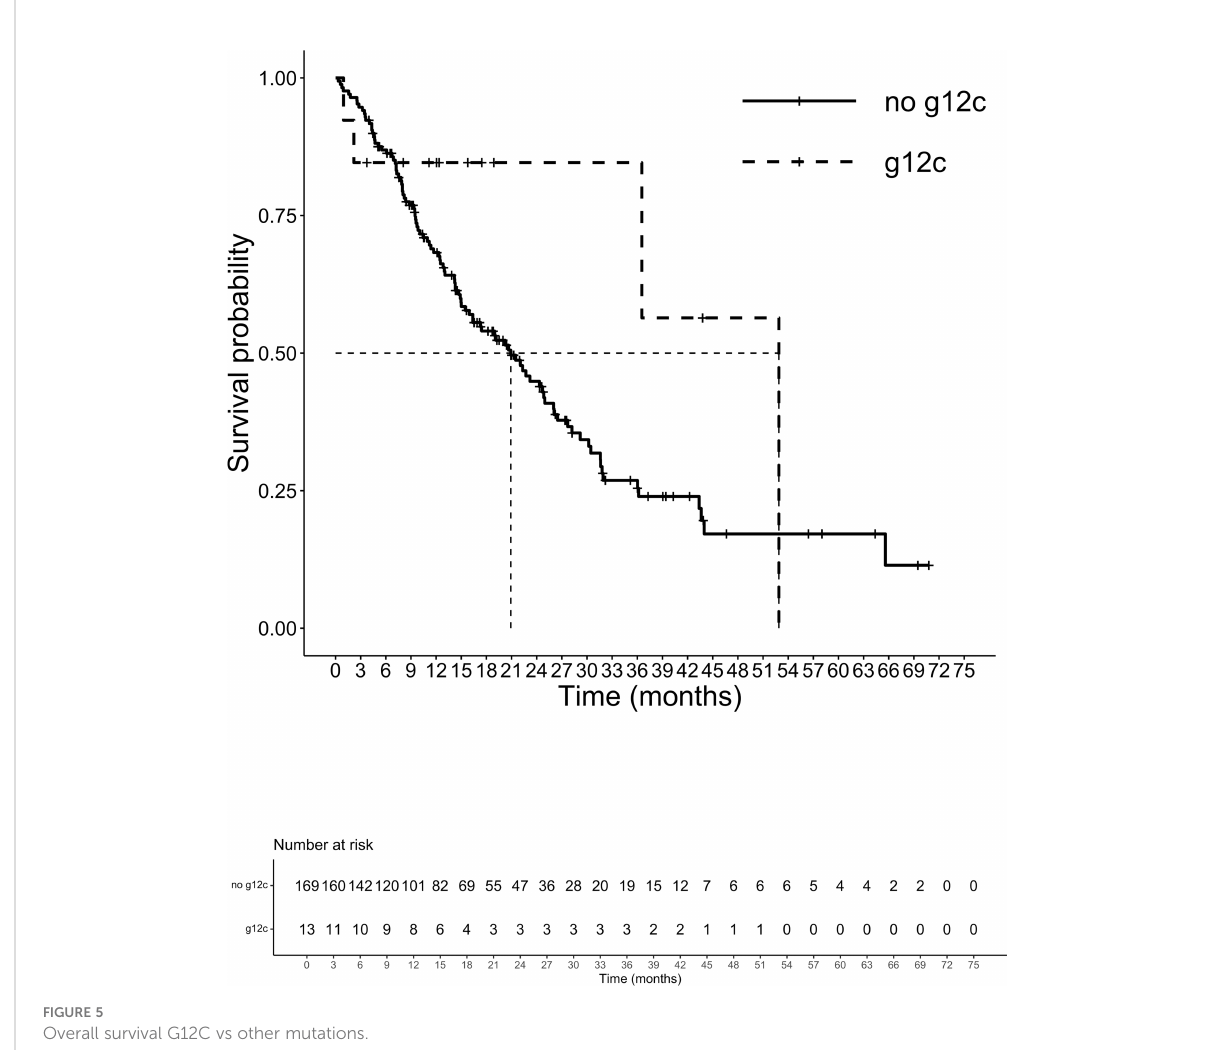
FIGURE 5 Overall survival G12C vs other